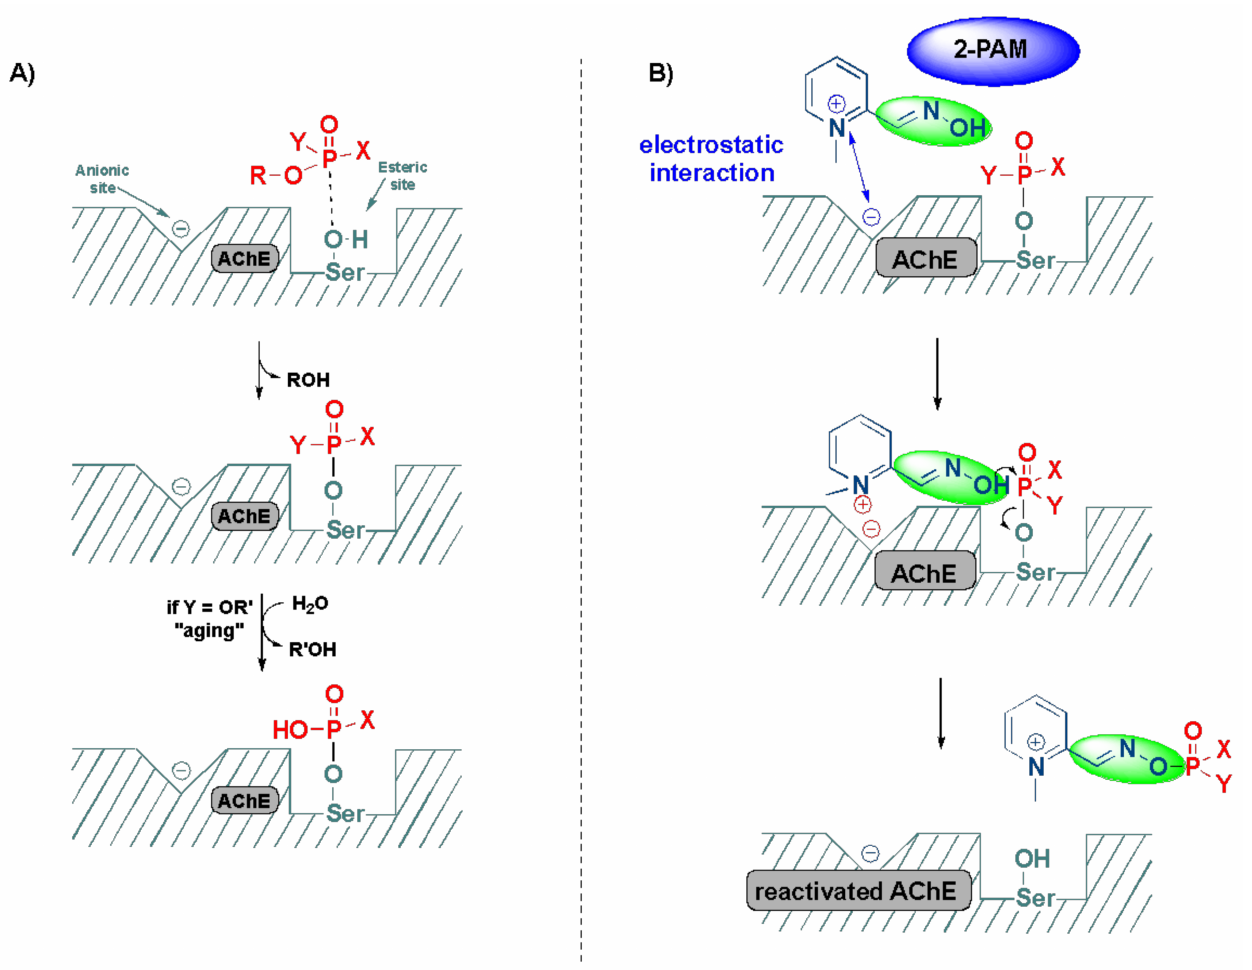
Figure 7. ( A ) Organophosphate poisoning of AChE. ( B ) Reactivation of AChE by